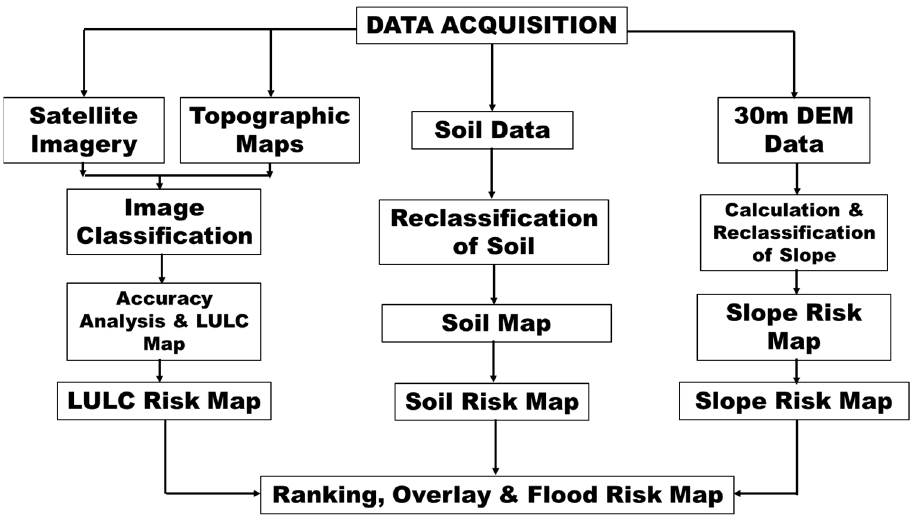
Figure 2. Flow model and research design.